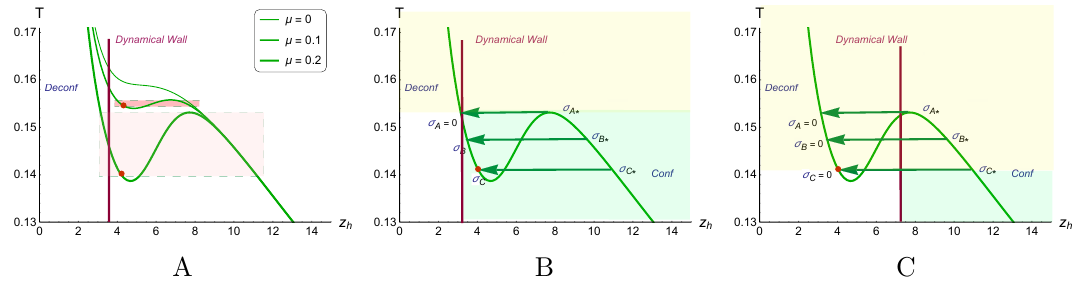
Figure 14 . Scheme of confinement/deconfuinement depending on location of the BH-BH phase transition points relative to the dynamic wall. T is in units of GeV and z h of GeV − 1